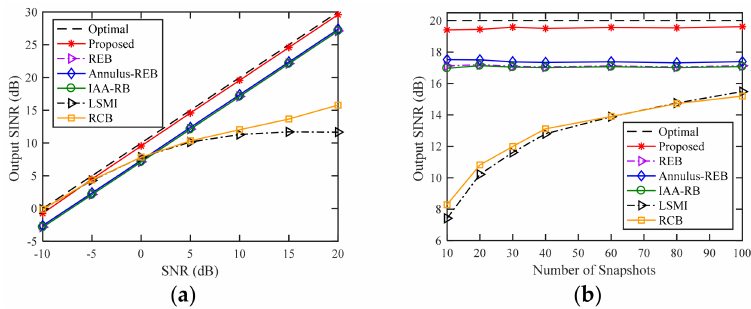
Figure 1. Output SINR versus ( a ) SNR ( b ) number of snapshots with exactly known DOAs and random sensor displacement.